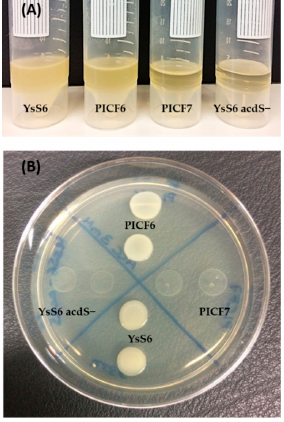
Figure 3. Demonstration of 1 ‐ aminocyclopropane ‐ 1 ‐ carboxylic acid (ACC) deaminase (ACD) ac ‐ tivity in liquid ( A ) and solid ( B ) Dworkin ‐ Foster (DF) medium using ACC as the only N source (see the Materials and Methods section for details). Pseudomonas fluorescens YsS6 and its ACD ‐ defective mutant derivative YsS6 acdS ‐ were used as positive and negative controls, respectively.